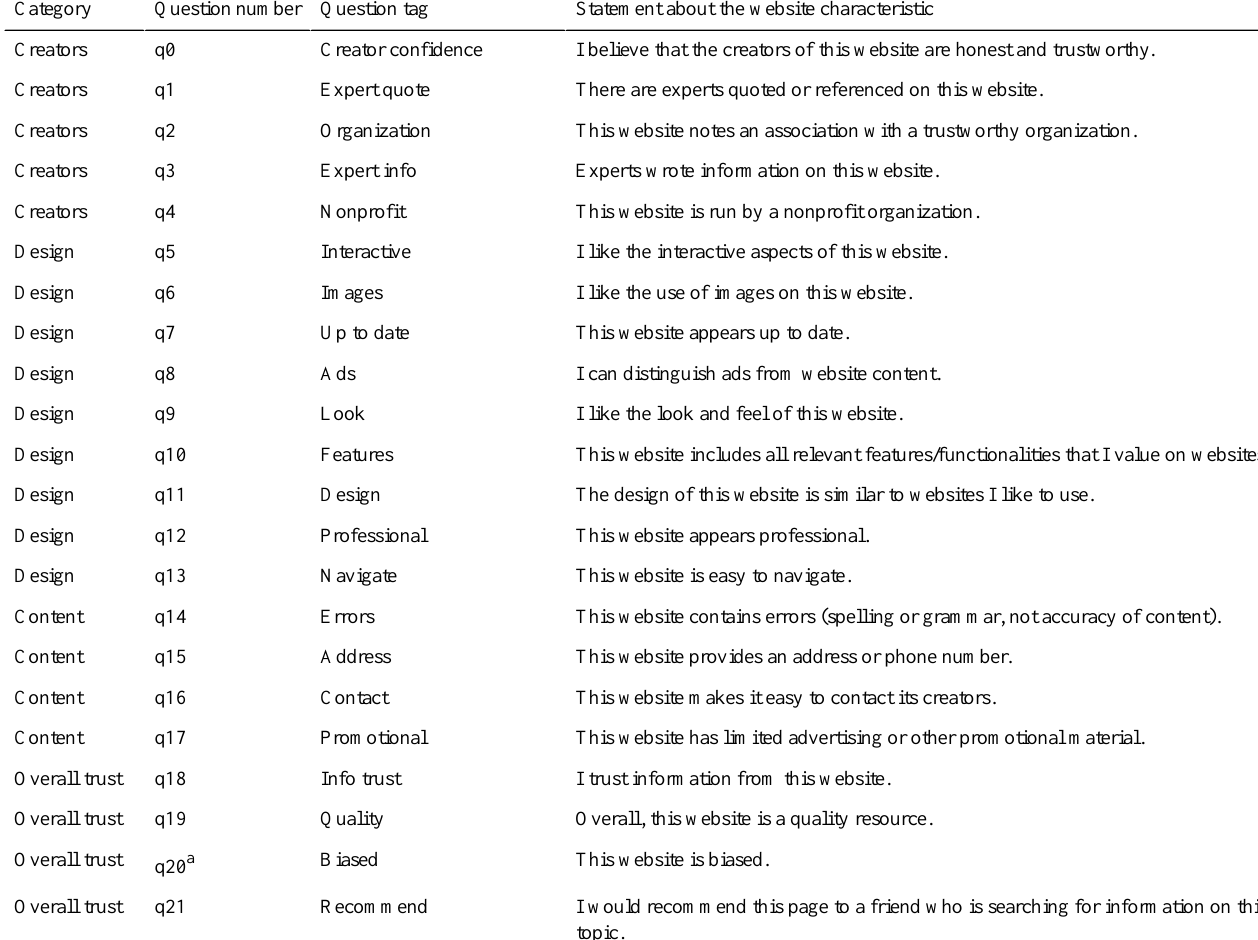
Table 1. Website